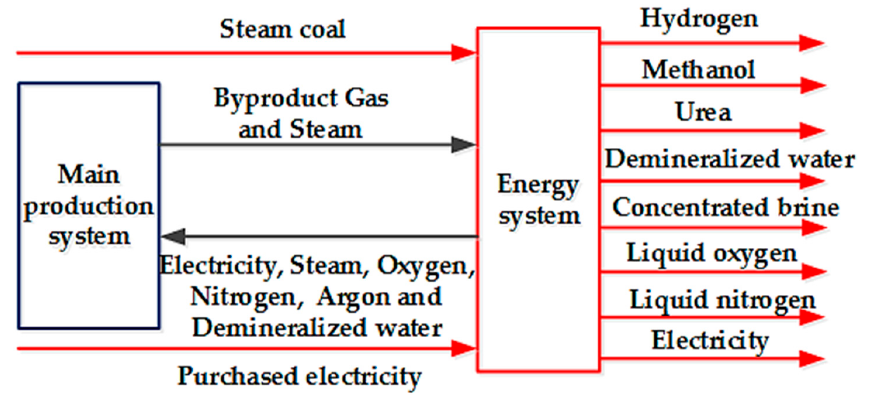
Figure 2. Input–output diagram of the energy source for an iron and steel enterprise.